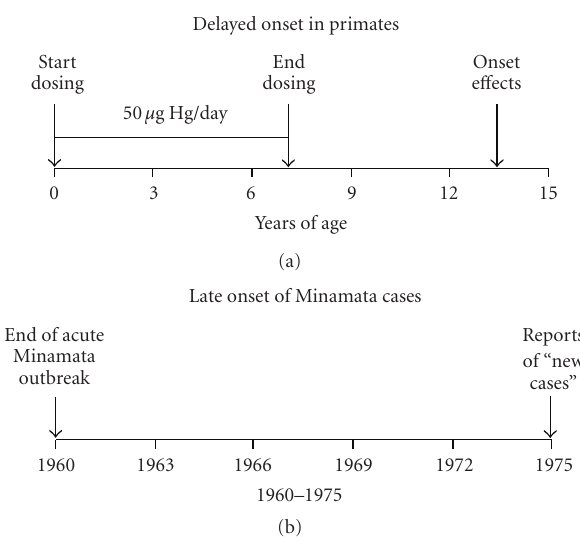
Figure 3: Depicting the phenomenon of delayed onset of neurotox- icity with methylmercury in nonnuman primates (a) and (b) in the Minamata population [18,